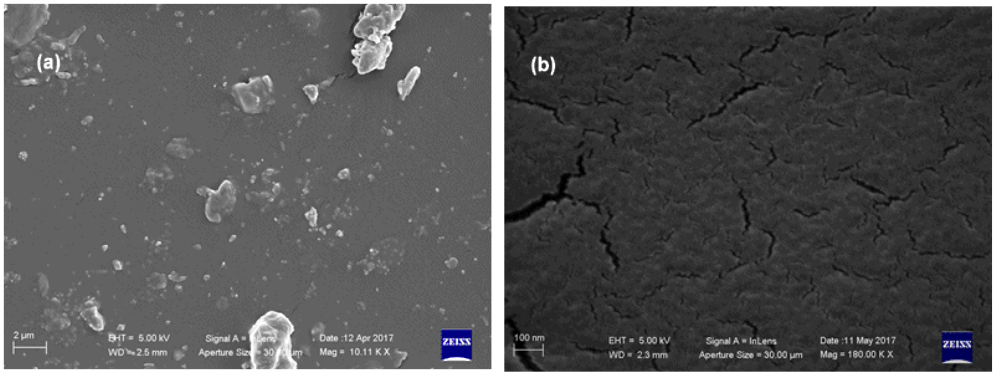
Figure 5. SEM microphotographs of BioPU_100 at different magnifications: ( a ) 10 Kx; ( b ) 180 Kx.